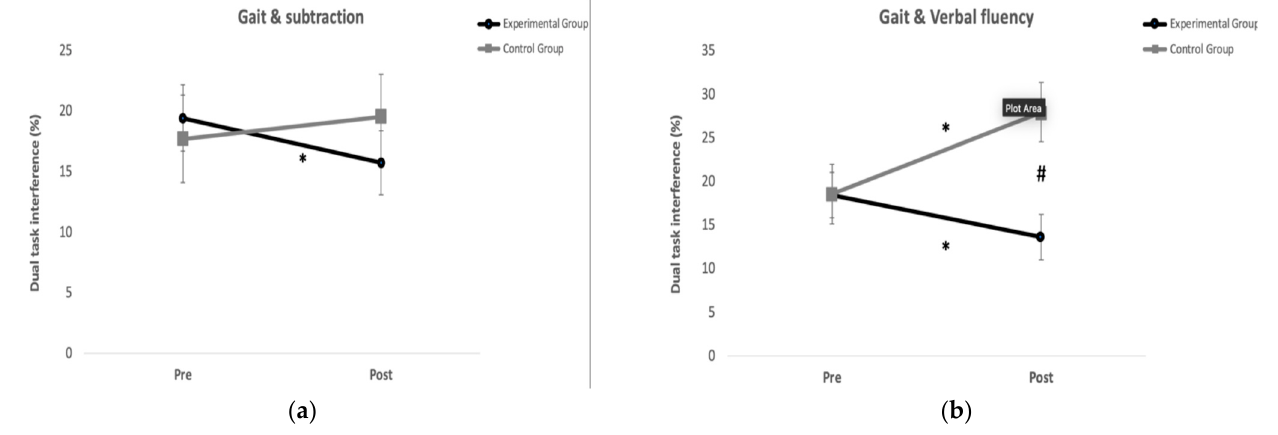
Figure 2. Results from the dual-task tests: ( a ) Experimental group reduced significantly the dual task interference for the Gait and subtraction test after the training program; ( b ) Experimental group reduced significantly the dual task interference for the Gait and subtraction test after the training program, while the control group increased it significantly. After the program training, the experimental group was significantly better than the control group in the Gait and Verbal fluency test. * Differences with pre ( p < 0.05). # Differences with experimental group ( p < 0.05). The ANOVA showed significant interactions (group*time) for dual task interference during the verbal fluency condition (F = 16.50, p < 0.01; η 2 = 0.49; observed power (OP) = 0.96) without significant group and time effects. The EG reduced significantly ( p = 0.026) the dual task interference after the program exercise, while there was a signifi- cant increase ( p < 0.01) in the CG. There was a significant difference ( p < 0.01) in the dual task interference between groups at Post evaluation (Figure